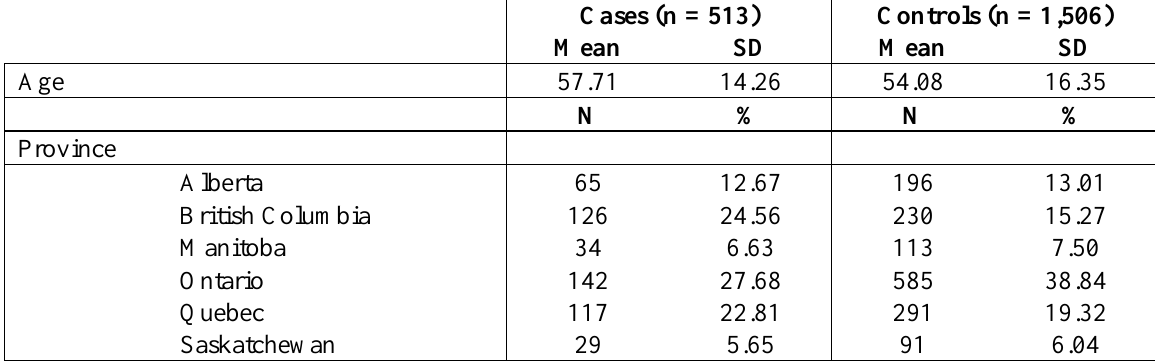
Table 1. Comparison of non-Hodgkin lymphoma cases and controls in the Cross-Canada Study of Pesticides and